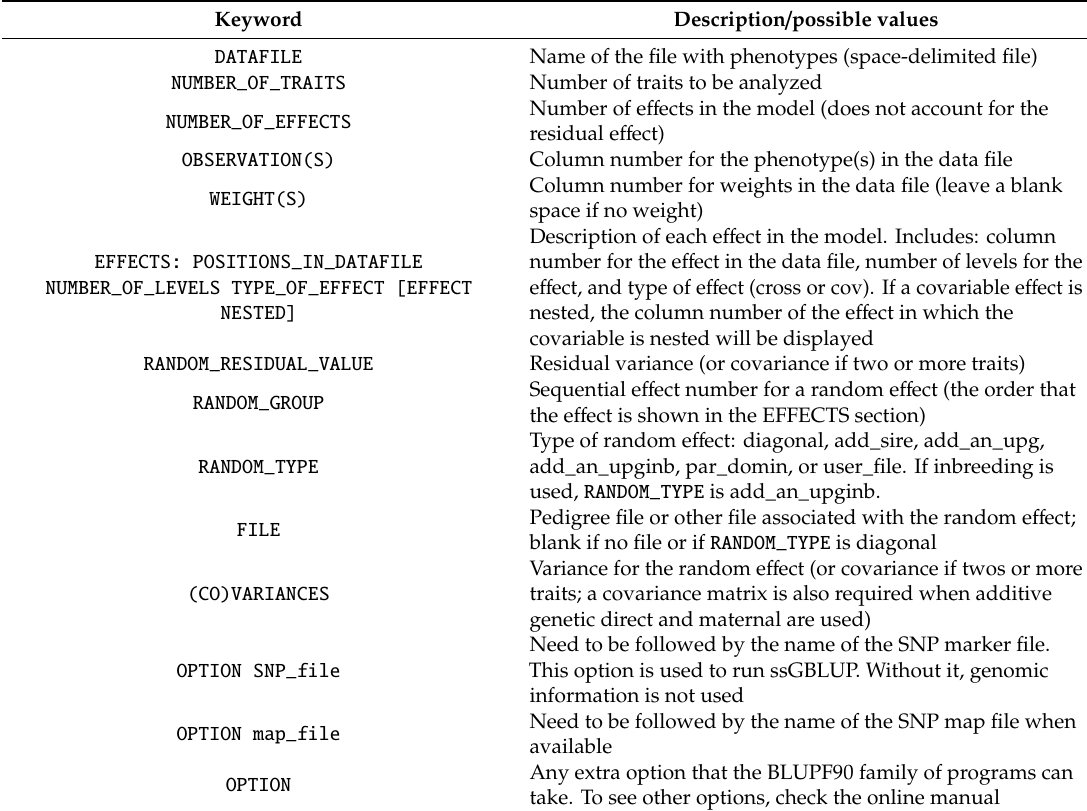
Table A4. Keywords in values in the new parameter file created by renumf90